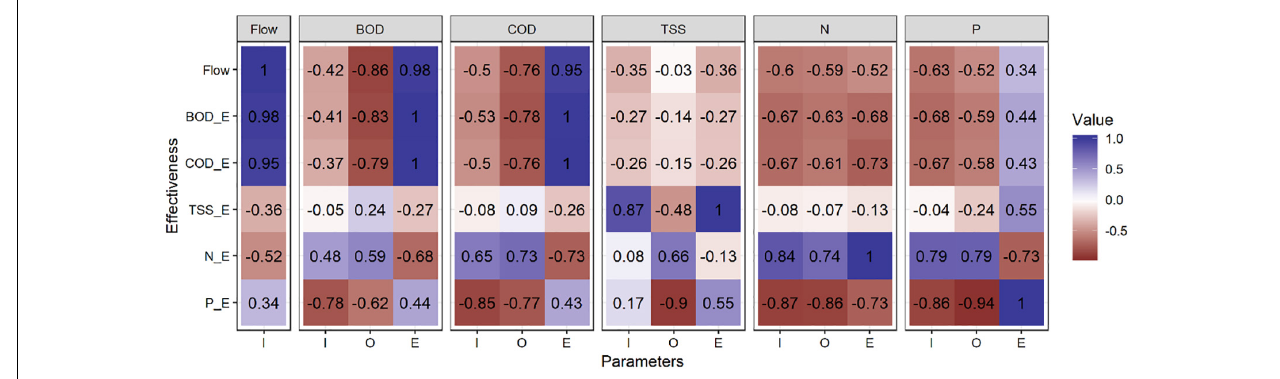
FIGURE 5 | Correlation between the main parameters analyzed in the study and their effectiveness. Codes: Input (I), Output (O), and Effectiveness in %